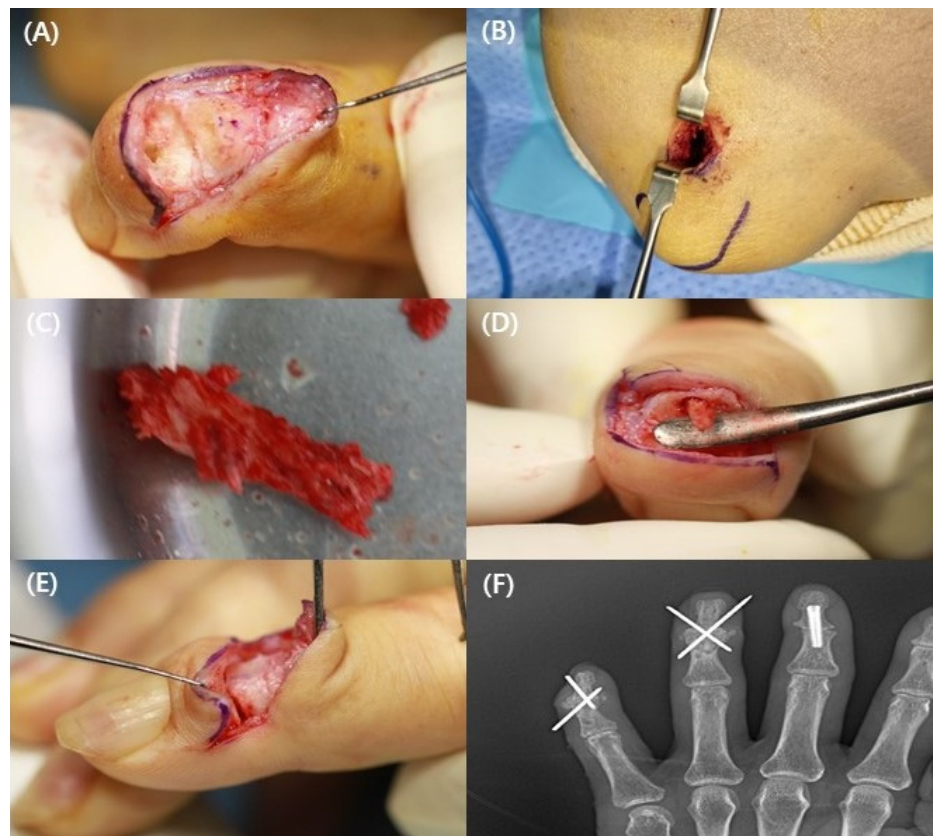
Figure 1. A 62-year-old woman underwent 3rd, 4th, and 5th distal interphalangeal joint (DIP) arthrodesis. ( A ) Two holes created by surgical burr within distal phalanx (DP) and middle phalanx (MP). ( B ) Bone grafting incision made at distal tip of olecranon. ( C ) The cortico-cancellous bone graft harvested from olecranon. ( D ) The bone peg impacted into hole created in MP with DIP joint flexion. ( E ) The distal aspect of bone peg impacted into DIP hole with DIP joint extension. ( F ) Postoperative plain radiograph fixated K-wires and inlay technique with cortico-cancellous bone graft.